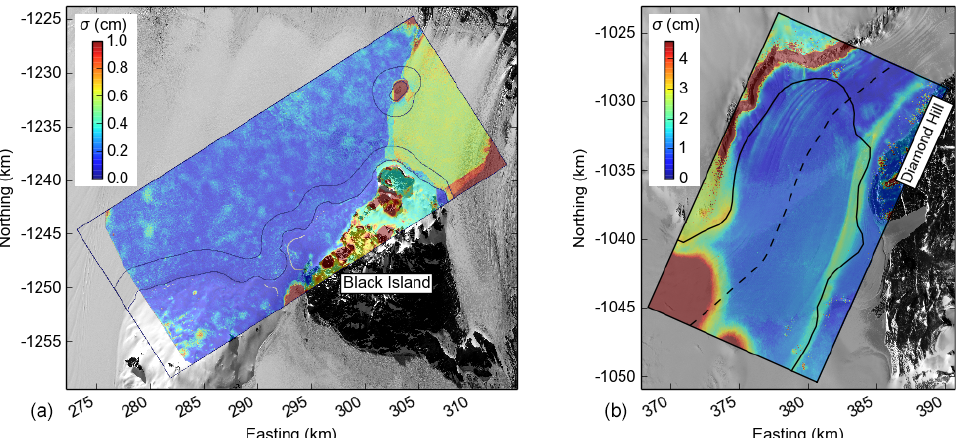
Figure 9. Standard deviations of misfits between modelled and observed DInSAR interferograms. Mean course of the grounding line as determined from DInSAR images in black. (a) Note the ice rise in the upper right corner and two jumps in standard deviations between this ice rise and the dry land for the southern McMurdo Ice Shelf. (b) Note the band of higher standard deviations from the Darwin Glacier’s shear margin from Diamond Hill towards the ice rise in the bottom left corner and the high standard deviations. The map background is contrast-stretched Landsat 8 panchromatic